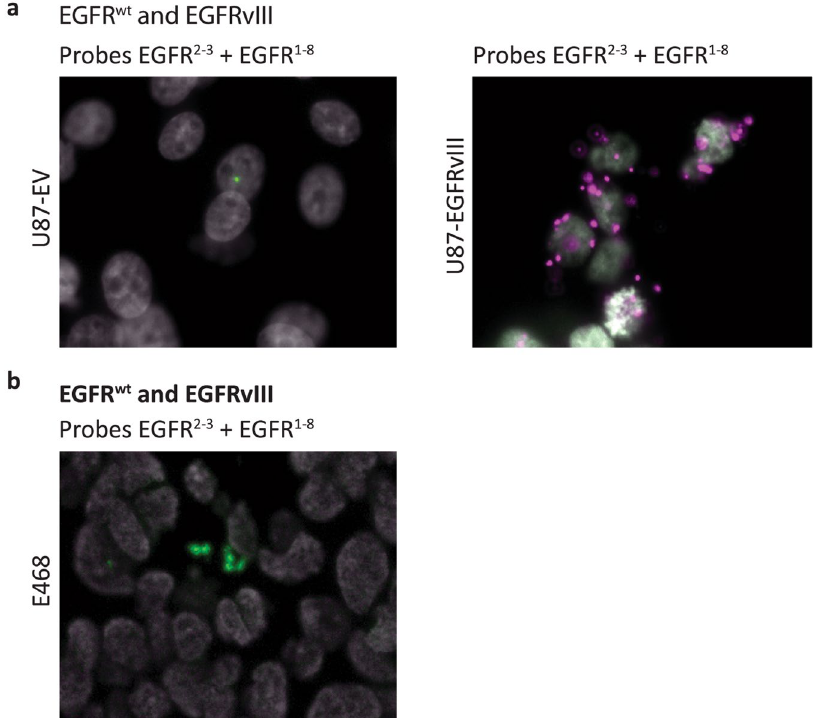
Figure 7. Multi-plex in situ mutation detection of EGFR using padlock probe rolling circle amplification on cell lines and E468 xenograft tissue. A) In situ duo-probe detection of EGFR wt and EGFRvIII transcripts using padlock probes EGFR 2,3 and EGFR 1–8 , on U87-EV and U87-EGFRvIII cells (original magnification 40x). B) In situ duo-probe detection of EGFR wt and EGFRvIII transcripts using padlock probes EGFR 2,3 and EGFR 1–8 , on E468 xenograft FFPE tissue (original magnification 20x). EGFR wt transcripts are displayed as green RCPs, EGFRvIII transcripts are displayed as magenta RCPs. Cell nuclei are shown in